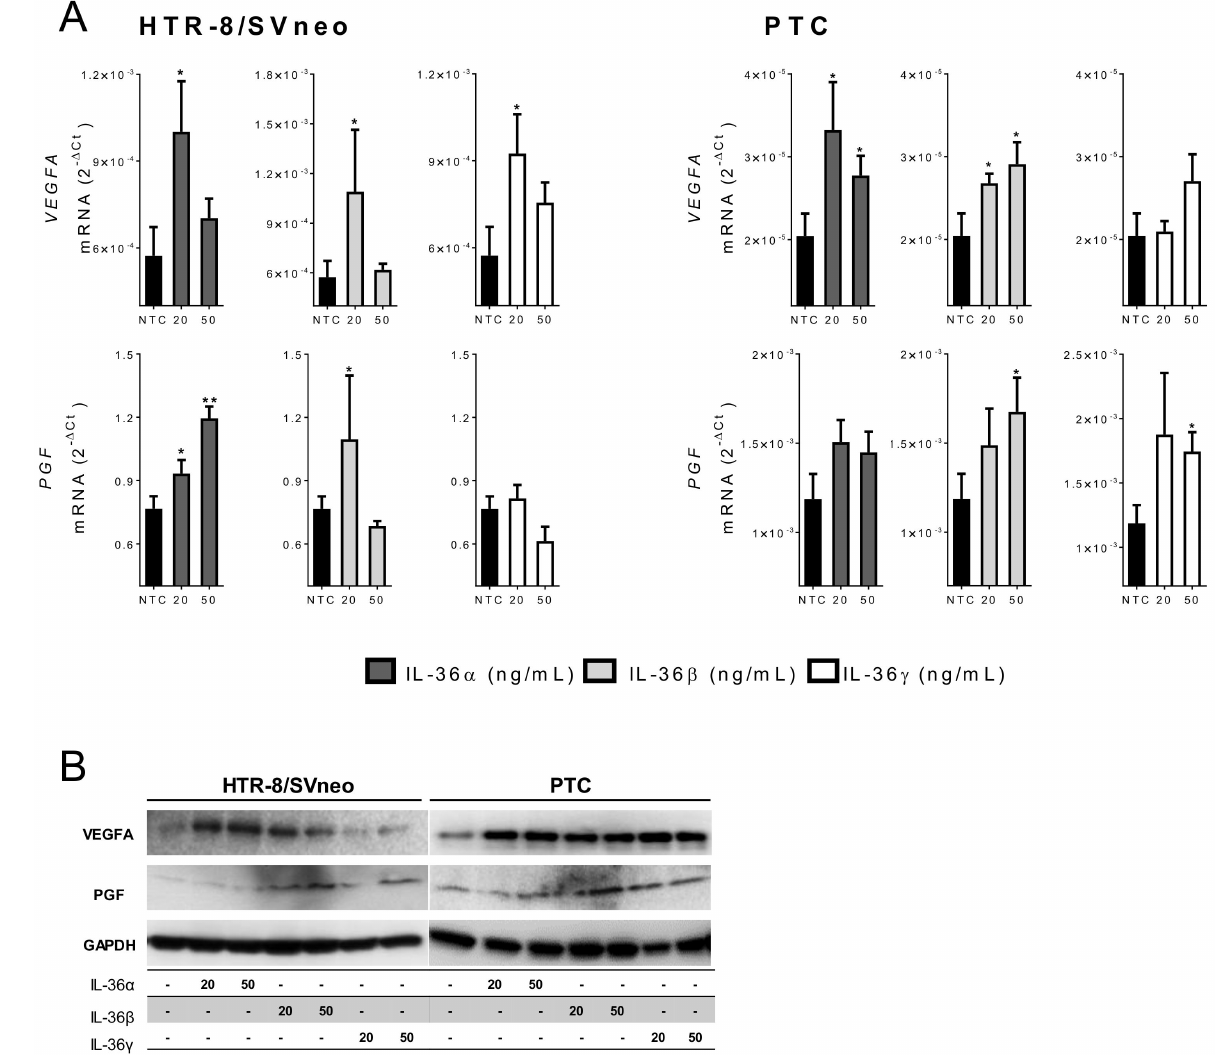
Figure 5. IL-36 ( α , β , and γ ) induced expression of angiogenic factors. ( A ) HTR-8/SVneo and primary trophoblast cells (PTC) were stimulated with 20 or 50 ng/mL IL-36 ( α , β , and γ ) for 24 h. The mRNA levels of VEGFA and PGF were determined by quantitative real-time PCR and normalized to GAPDH using the 2 − ∆ Ct method. Results from three independent experiments are shown as mean ± SEM. NTC: Non-treated cells. Unpaired two-tailed Student’s t-test with Welch ´ s correction. * p < 0.05, ** p < 0.01 for significant differences to NTC controls. ( B ) VEGFA, PGF, and GAPDH proteins were detected by Western blotting using 20 µ g cell lysate from HTR-8/SVneo and PTC stimulated for 24